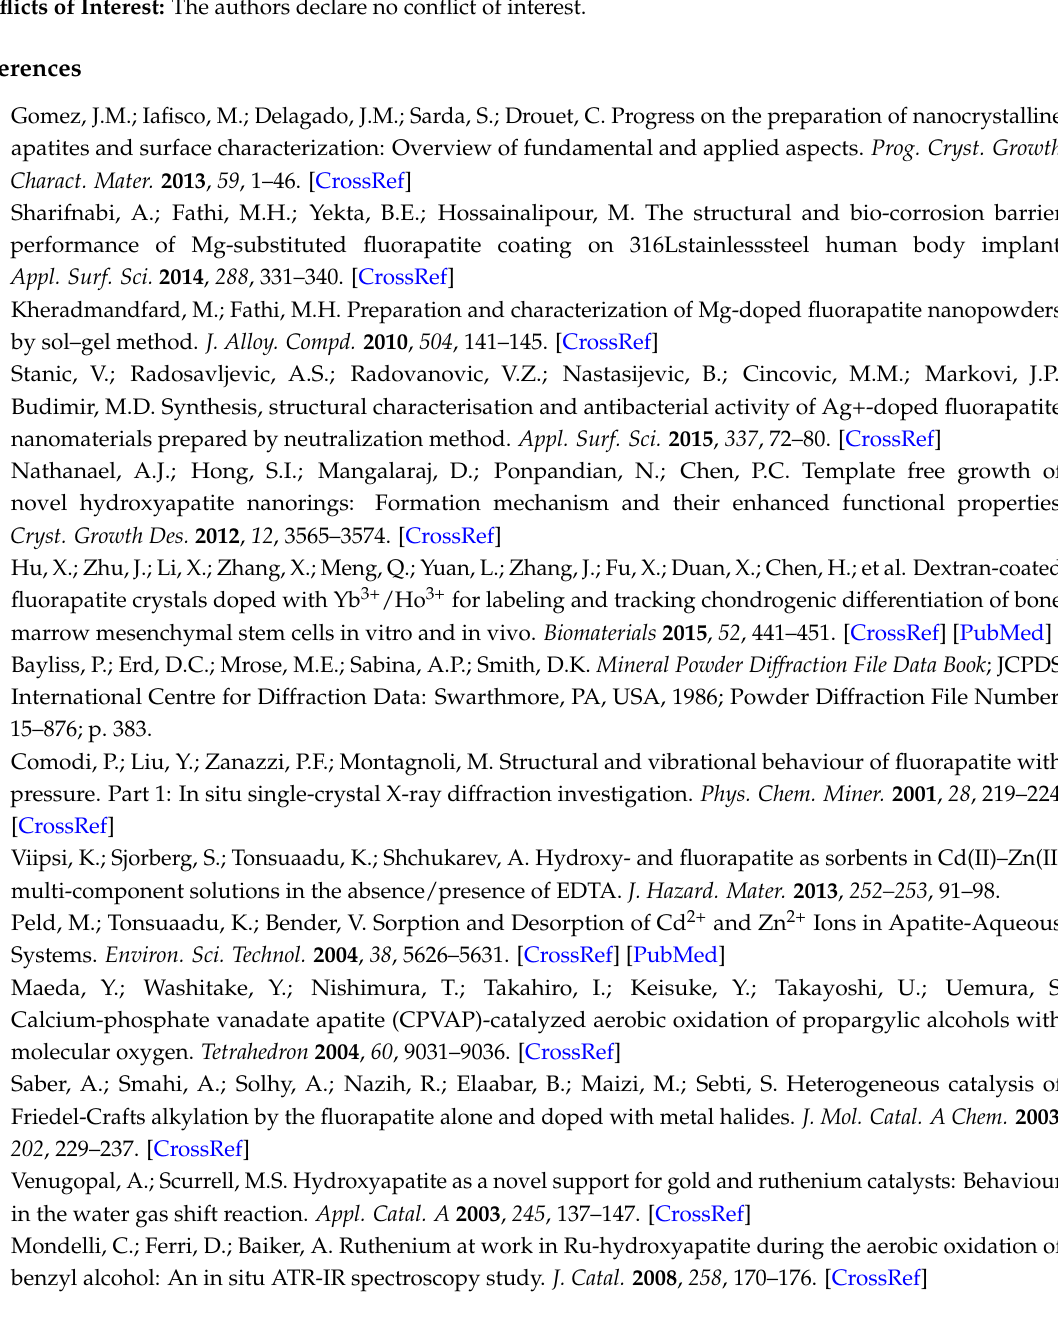
Table S1: Elemental analysis by EDX and ICP-OES, Table S2: Statistical report using ANOVA, Table S3: Optimization of the amount of Sm-FAp/Glycine as catalyst in the model reaction a , Figure S1: X-ray diffraction pattern of ( a ) FAp/without amino acid; ( b ) Sm-FAp/without amino acid; ( c ) Sm-FAp/Glutamic acid; ( d ) Sm-FAp/Aspartic acid;+.2 ( e ) Sm-FAp/Glycine; ( f ) Sm-FAp/Histidine before annealing at 350 ◦ C, Figures S2–S5: FT-IR, 1 H-, 15 N-, 13 C-NMR spectra of 5-(2-nitrophenyl)-1,2,4-triazolidine-3-thione, Figures S6–S17: 1 H-, 13 C-, 15 N-NMR spectra of entries